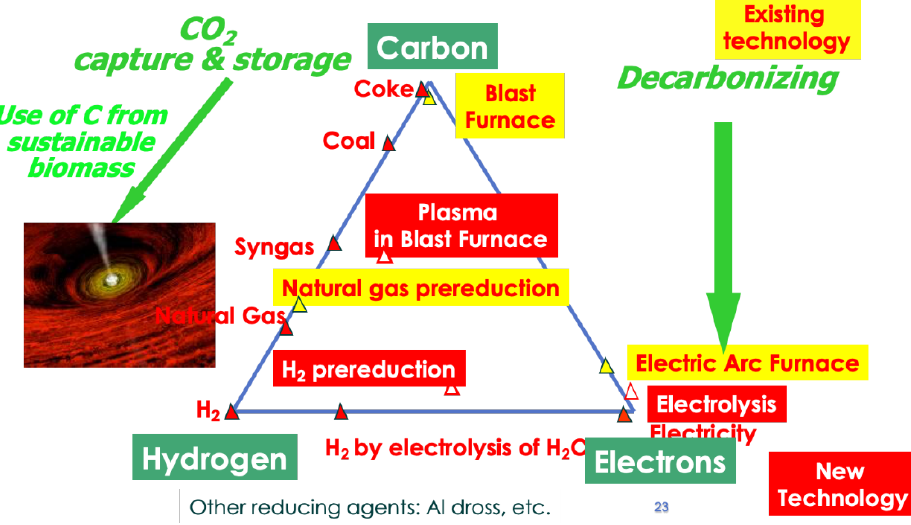
Figure 17. Practical ways to reduce iron ores: process route for iron and steelmaking.